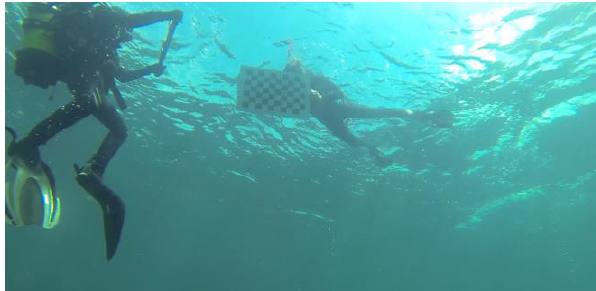
Figure 18 Procedures of